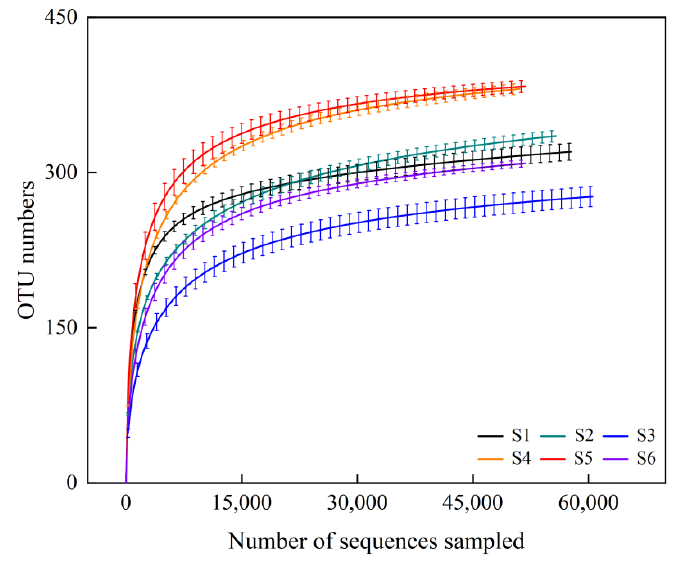
Figure 3. Dilution curve of samples at 97% similar level.